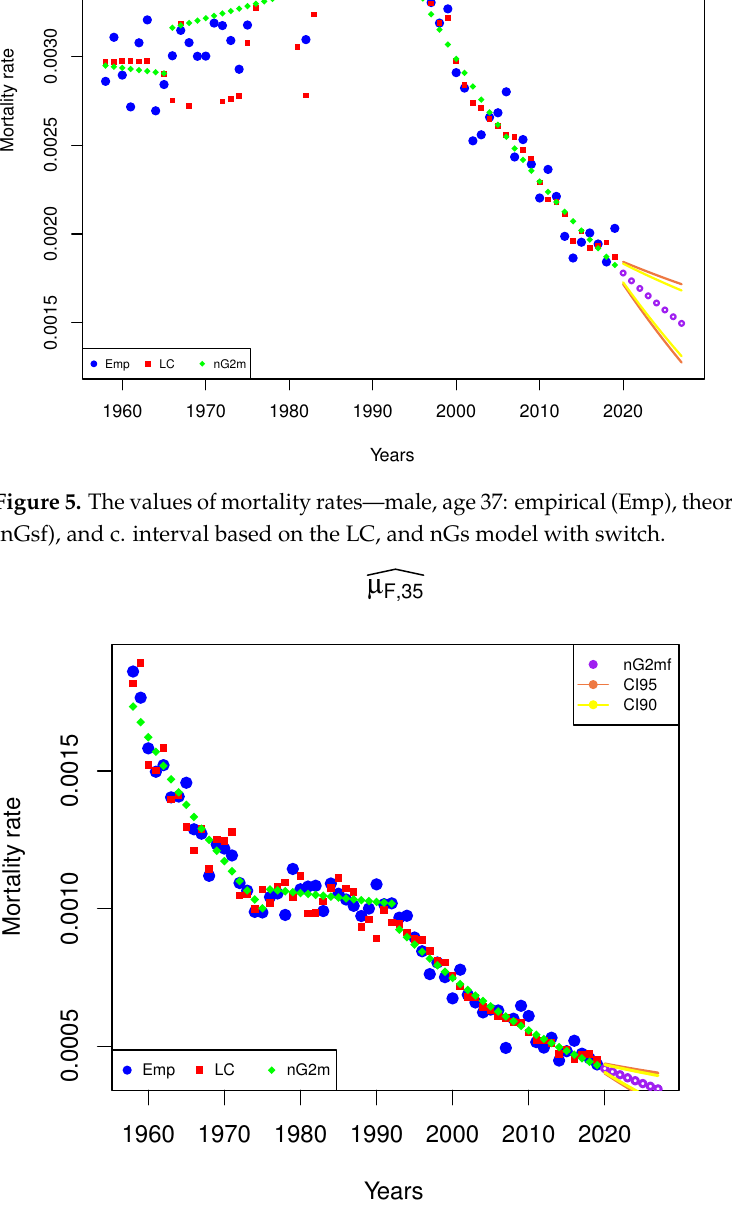
Figure 6. The values of mortality rates—female, age 35: empirical (Emp), theoretical (LC, nGs), forecasts (nGsf), and c. interval based on the LC, and nGs model with